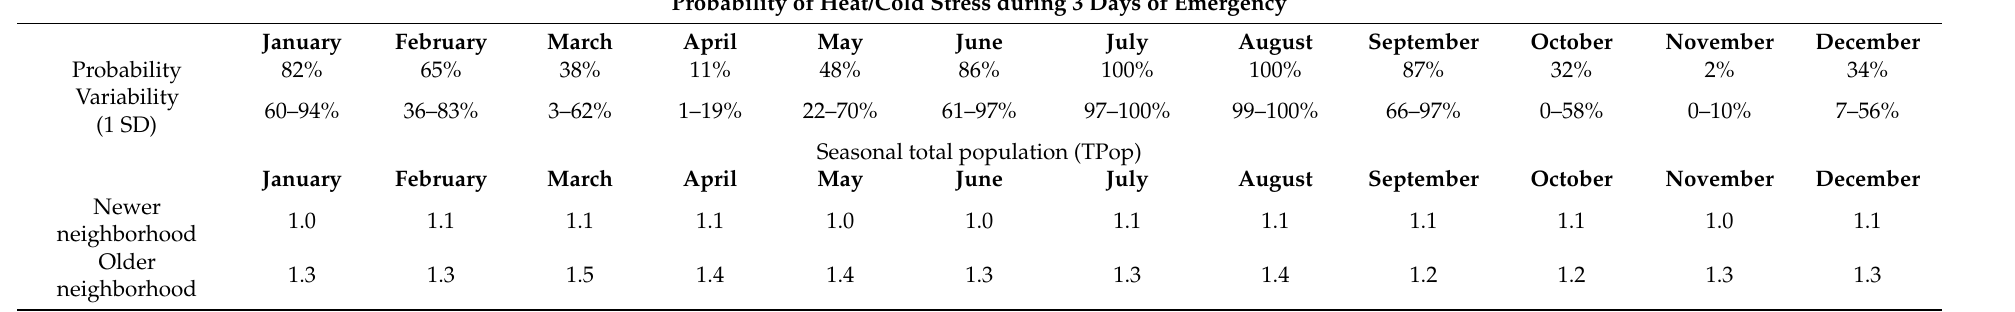
Table 3. Seasonal stressors in Mitzpe Ramon. Probability of experiencing extreme weather in an interval of three days, and total population in the neighborhoods discussed in the text and shown in Figure 3. Variability in monthly probability was calculated based on the variability in the number of days with heat or cold stress in the 16 years of data. Monthly TPop represents average values of population between July 2016 and May 2020, and as tourism is growing fast (and is directly affected by disasters such as the Covid-19 pandemic) the numbers are only used for qualitative insights on